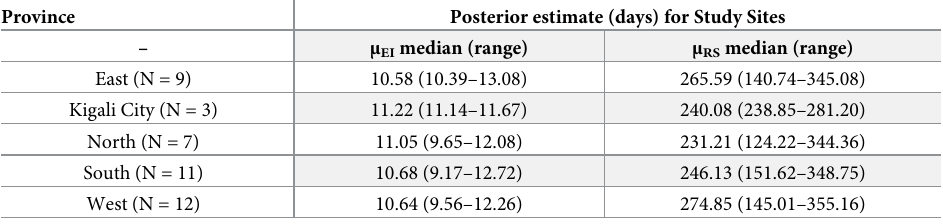
Table 1. Mean posterior estimates for two epidemiological parameters of malaria. μ EI is the average duration of parasite incubation in humans and μ RS , the average duration of subpatent infection. The province median and range of the mean estimate for sites within a province are shown for regional